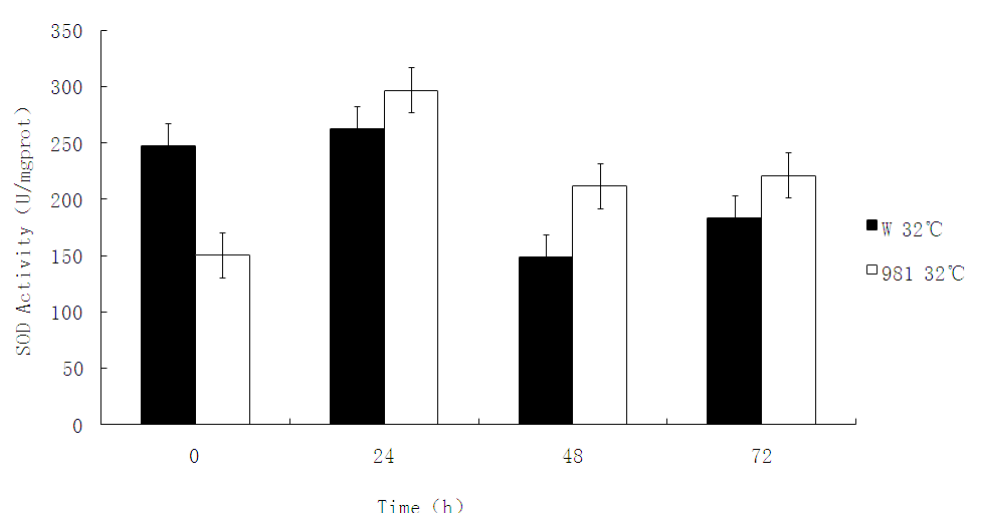
Figure 6. SOD activity assay of W and 981 at 32 °C. Each datum represents the mean of three determinations on the same sample with standard